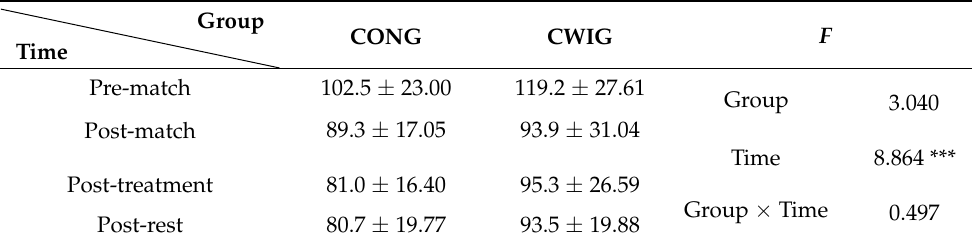
Figure 2. Heart rate during a Taekwondo match. Table 2. Change in malondialdehyde (MDA) concentration after cold-water immersion (CWI) (unit/ µ